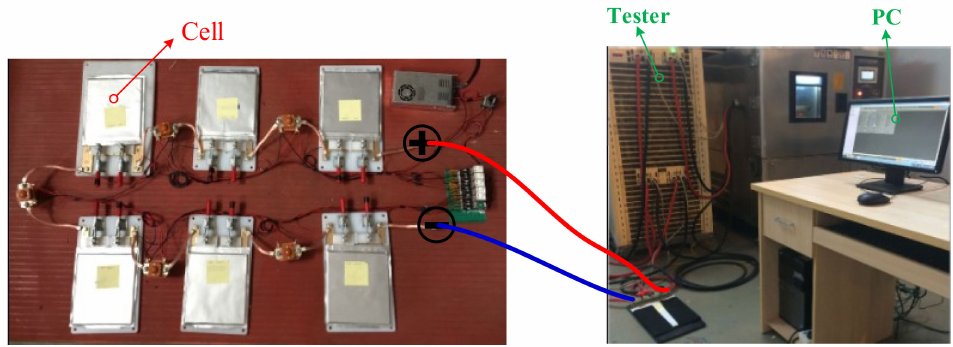
Figure 10. Schematic of the battery test bench.